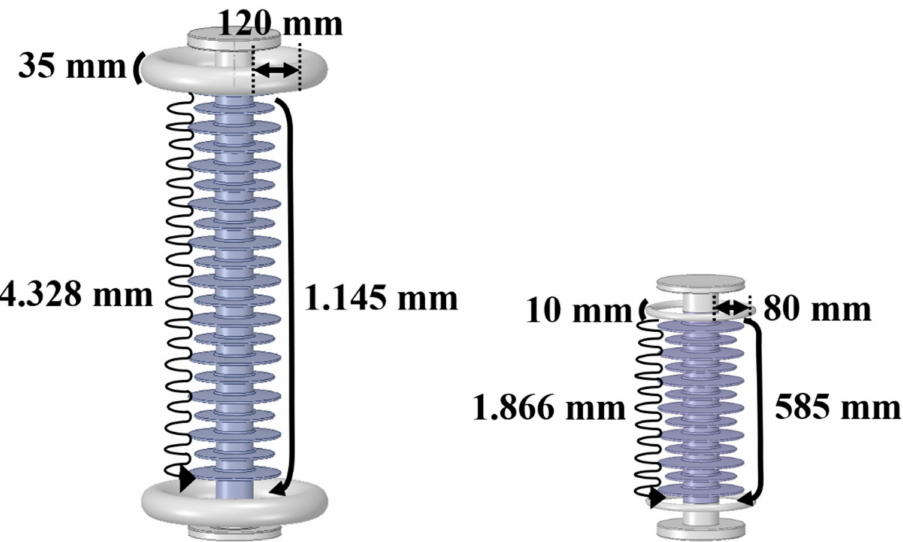
Figure 9. Final model of the post and the interlay